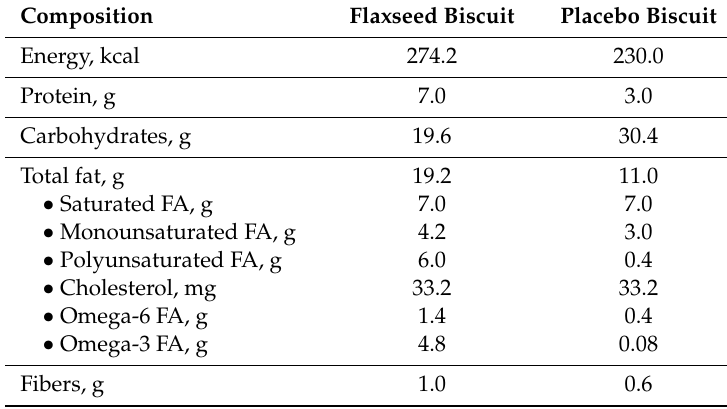
Table 2. Nutritional value of experimental biscuits per daily dose. Composition of experimental biscuits (expressed as per daily dose). Abbreviations: FA—fatty acids.